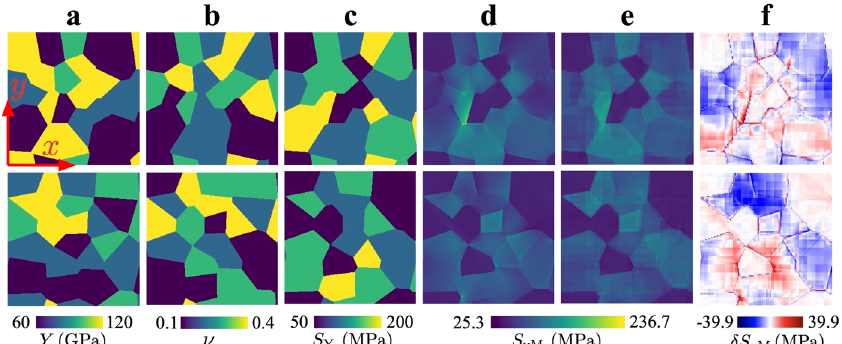
Fig. 6 Stress distribution in case of elasto-plastic material response. Comparison for two different topologies obtained by U-Net predictions ( e ) of the von Mises stress spatial distribution and the corresponding DAMASK calculations ( d ) for the shown input material property distributions of Young ’ s modulus ( a ), Poisson ratio ( b ) and Yield stress ( c ). The error between U-Net and DAMASK predictions is shown in ( f ). The applied strain is chosen such that the von Mises stress depends on both elastic constants and the yield stresses, i.e., the spatial pattern of the von Mises stress is neither similar to the elastic constant distribution nor to the yield stress